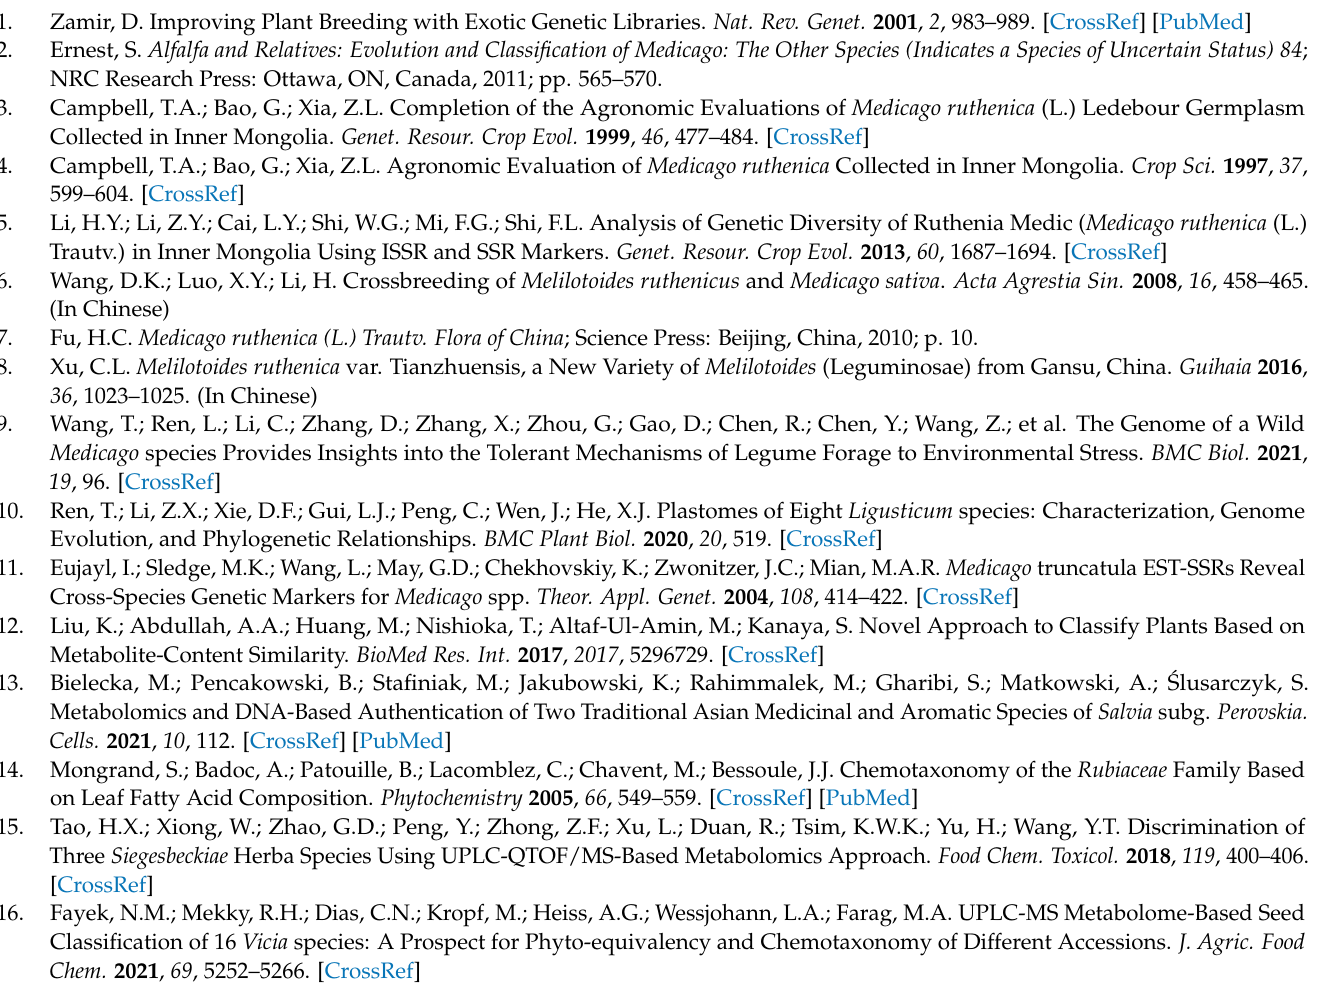
Figure S2: Volcano plot analysis. Table S1: Statistic Reads of RNA-Seq data. Table S2: Unigenes functional annotation statistics table. Table S3: Result of GO database. Table S4: KEGG pathway analysis. Table S5: Differential expressed genes of PFM and YFM. Table S6: Upregulated genes in YFM vs. PFM. Table S7: Downregulated genes in YFM vs. PFM. Table S8: Specific quantitative primers for